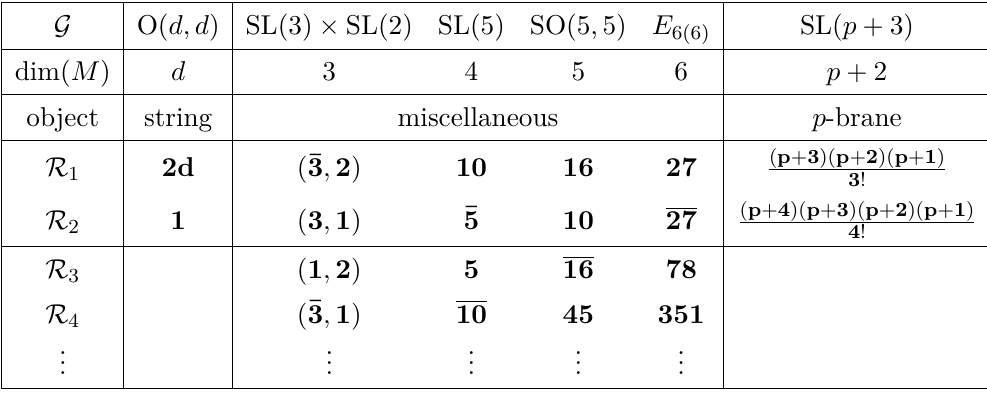
Table 1 . The relevant representations of duality/generalised geometry groups G including the begin of the tensor hierachy for the E d ( d )